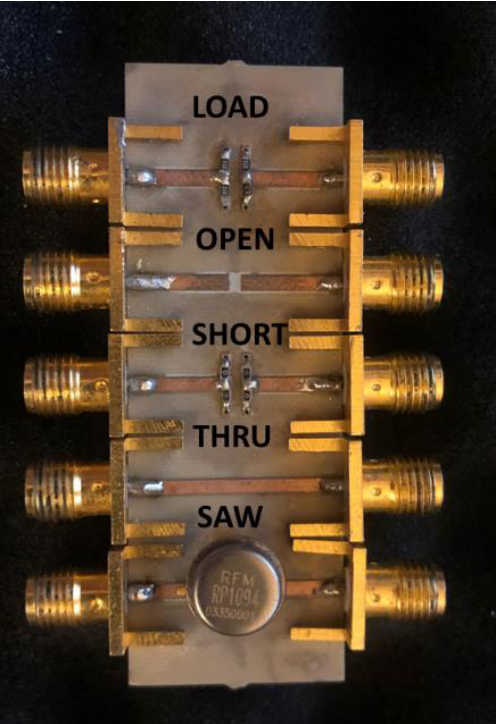
Figure 2. Photo of the developed custom SAW test fixture with on board SOLT calibration kit.